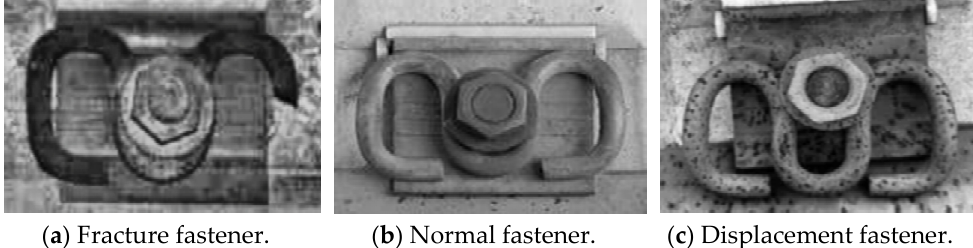
Figure 1. Forms of rail fasteners.